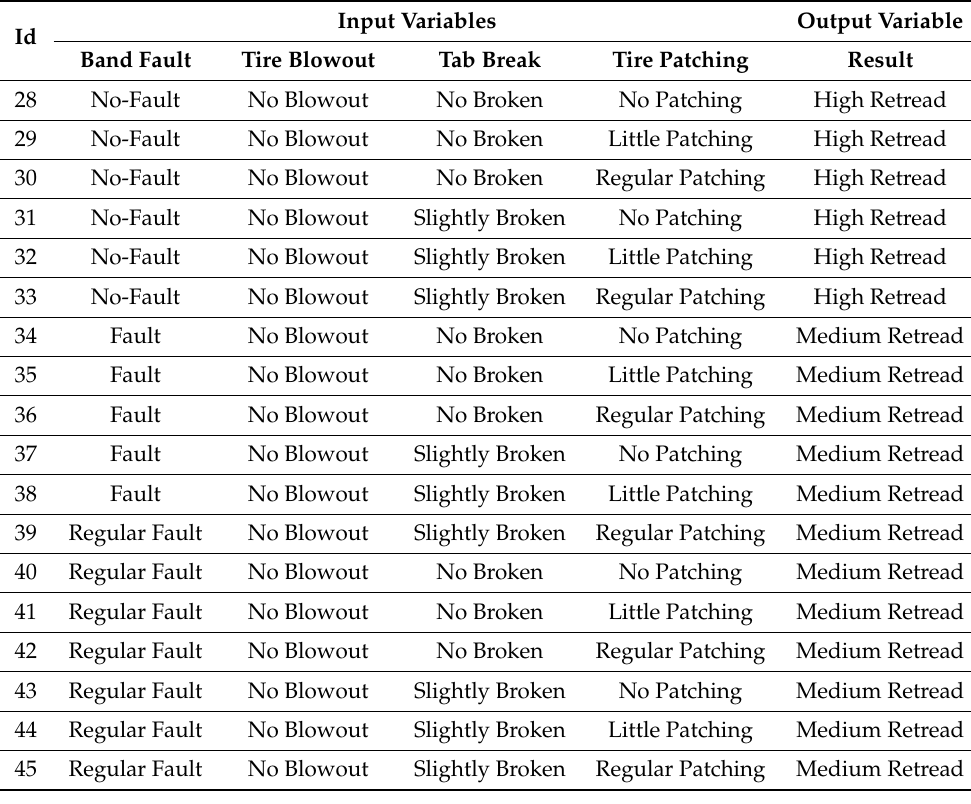
Table 3. Distribution of Fuzzy Rules as a Result of Medium or High Retread.